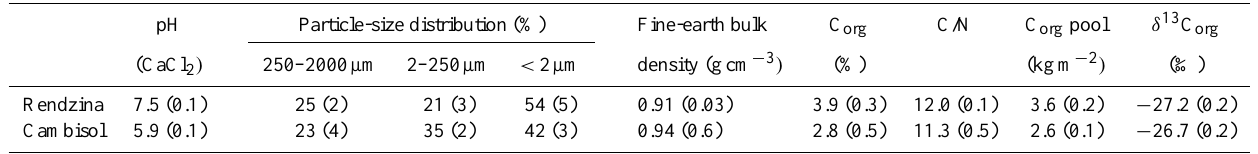
Table 1. Properties of the top 0–10cm of soil. Five soil cores (5cm in diameter) were taken from both soil types. The values are means ± standard